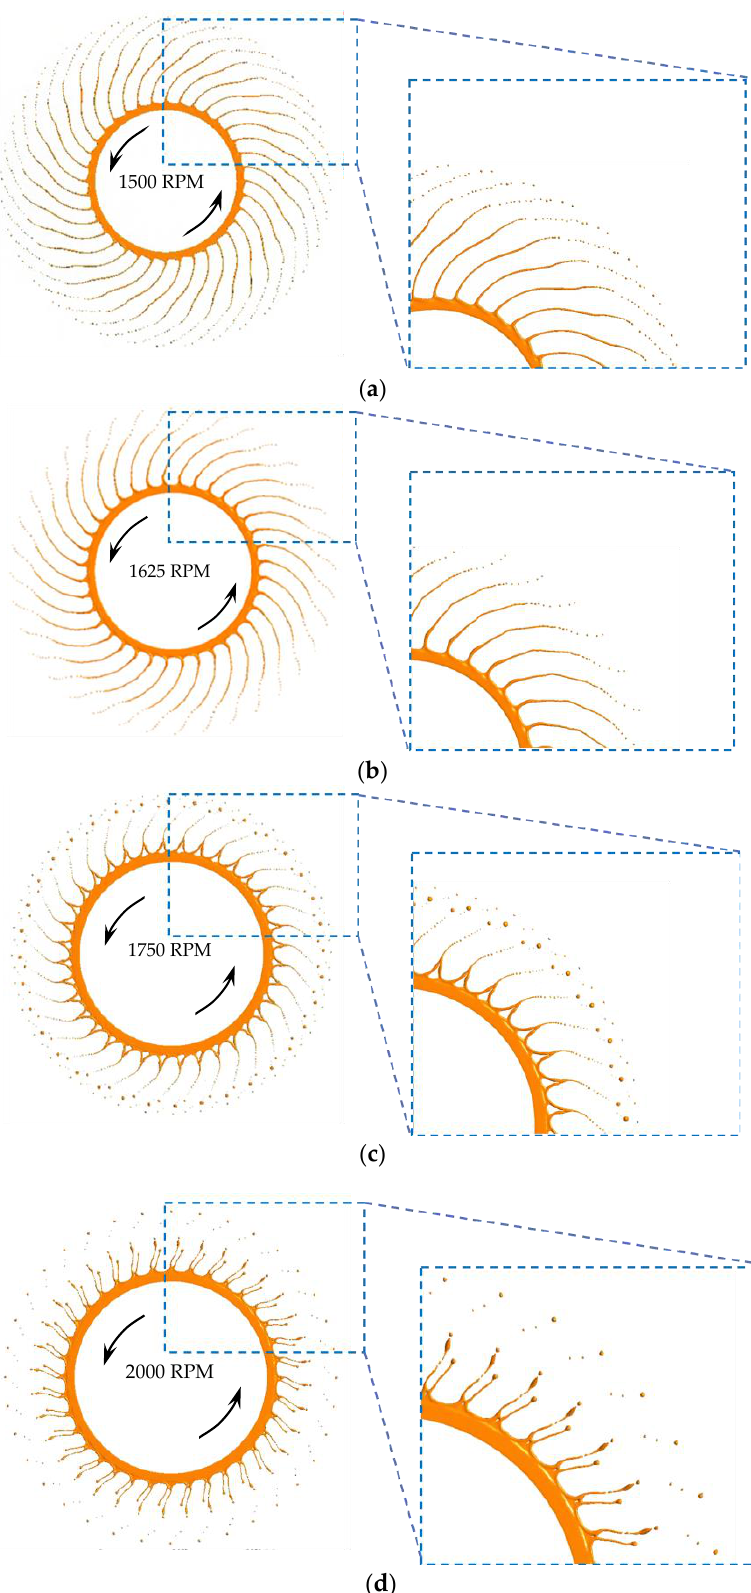
Figure 6. CFD simulation results on centrifugal granulation of molten slag at a flowrate of 3 kg min −1 and different cup spinning speeds. ( a ): Cup spinning speed = 1500 RPM; ( b ): Cup spinning speed = 1625 RPM; ( c ): Cup spinning speed = 1750 RPM; ( d ): Cup spinning speed = 2000 RPM.